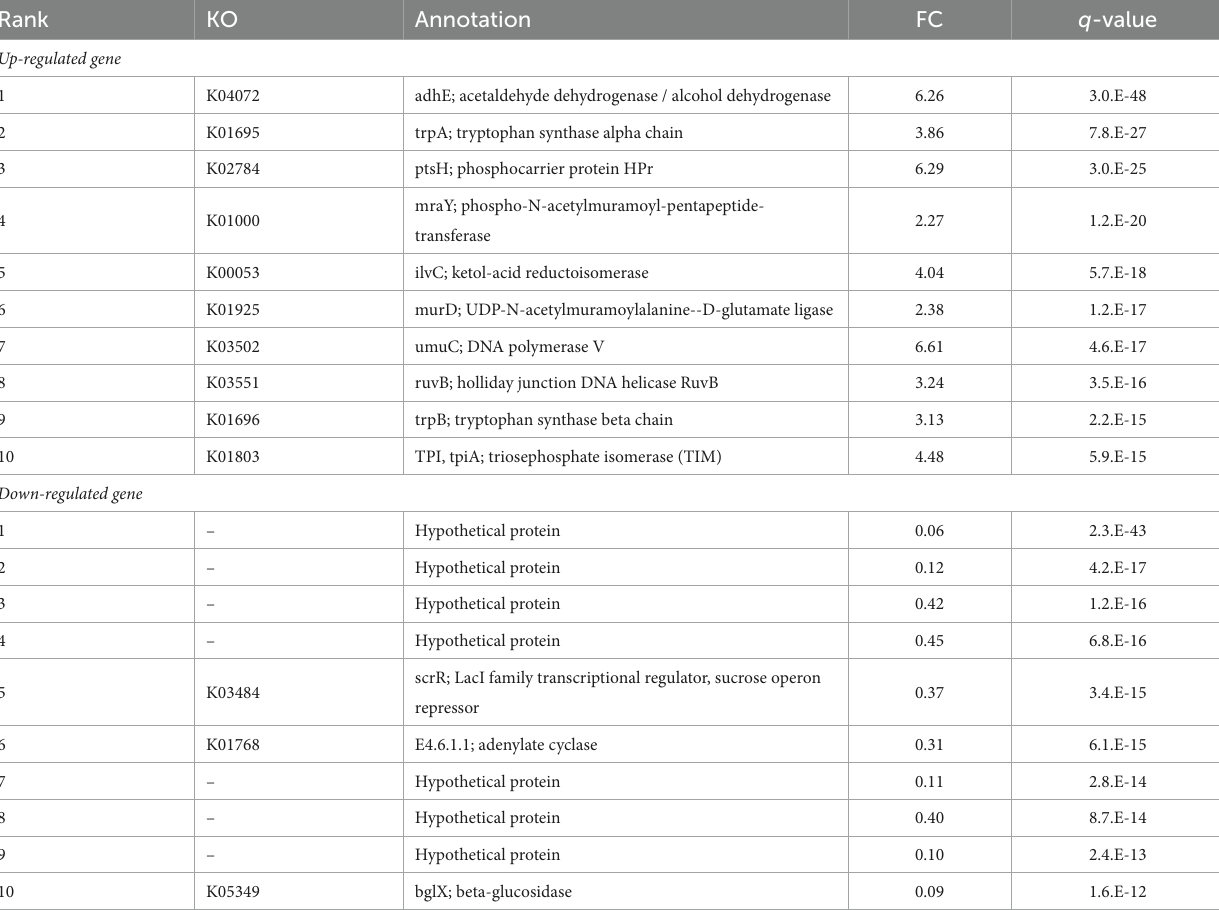
TABLE 1 List of top 10 up- and down-regulated genes of B. breve MCC1274 in the co-culture with IECs compared with the mono-culture. Rank KO Annotation FC q -value